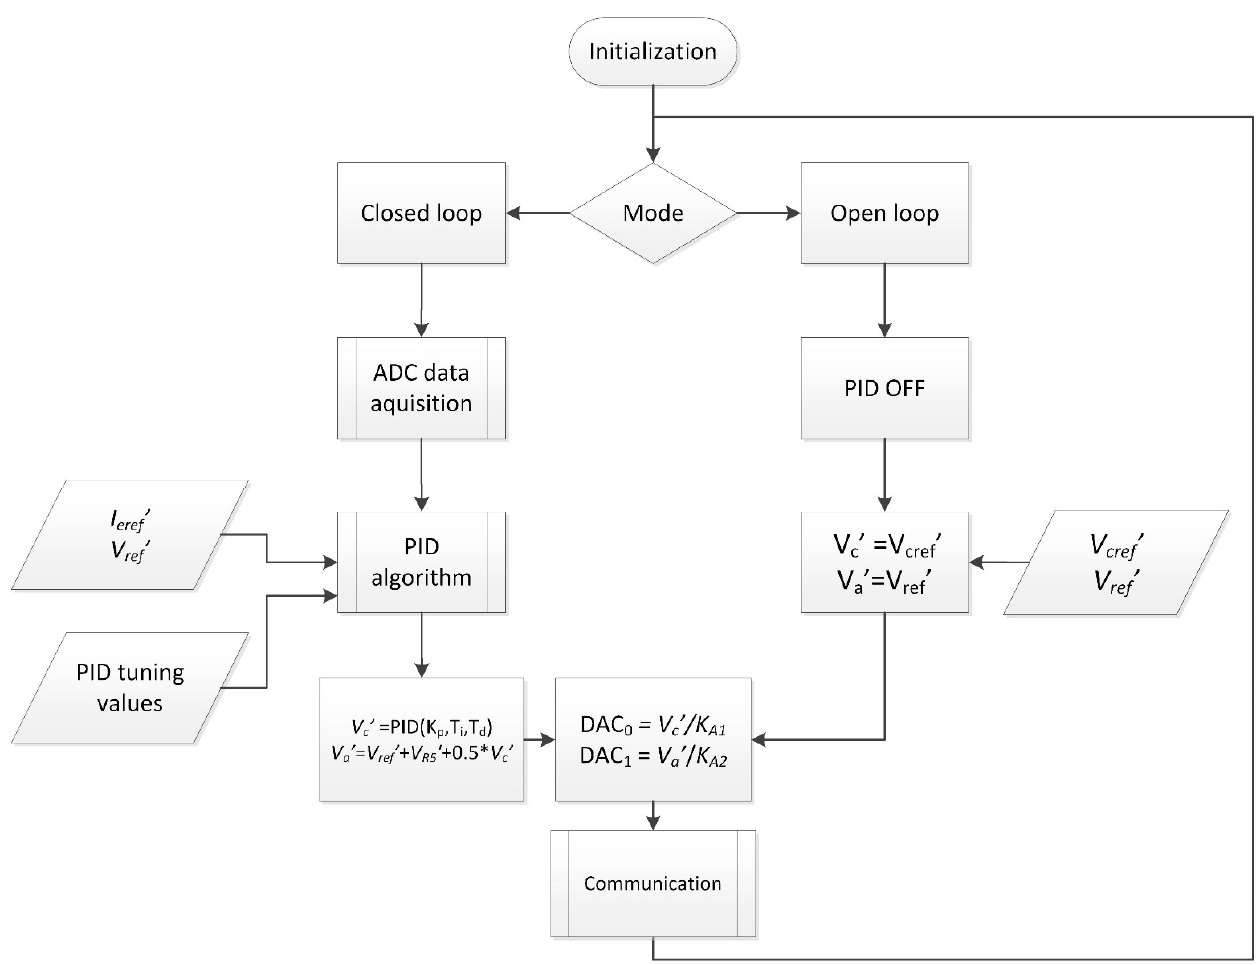
Figure 3. The general algorithm of the presented control